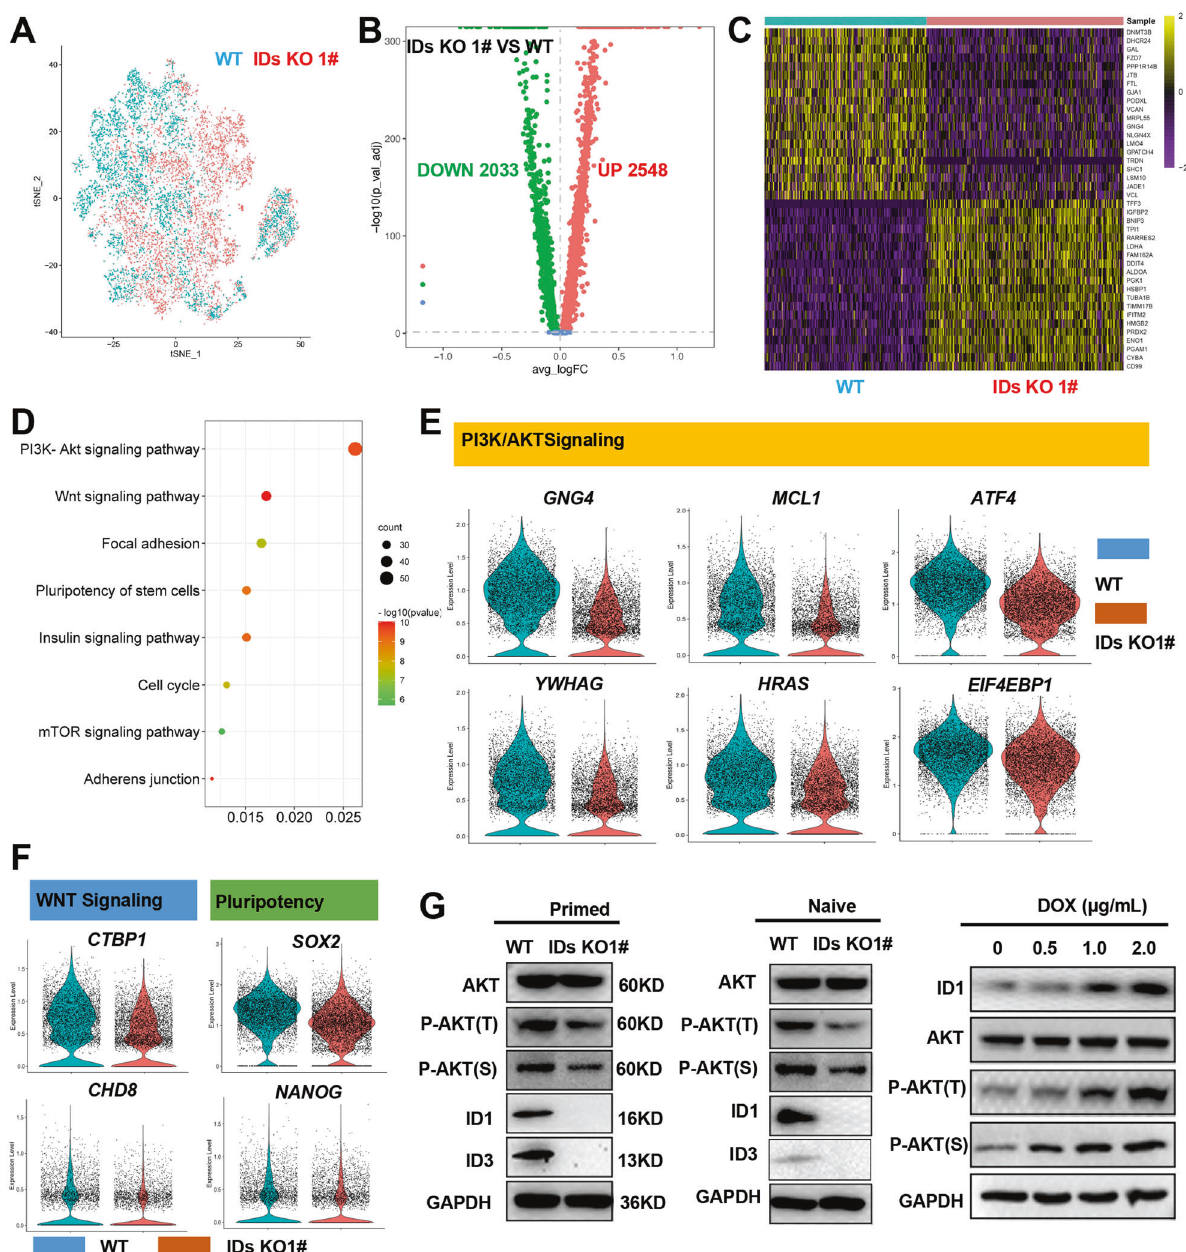
Fig. 4 ID1 and ID3 double knockout reduces AKT phosphorylation of hESCs. A scRNA-seq t-SNE plot of the WT and double knockout line, WT cells are blue, and double knockout cells are red. B Volcano plots showing the fold change (X axis) between the WT and double knockout line cultured in E8 medium. In IDs KO cell, the number of genes with upregulated expression is 2548, and the number of genes with downregulated is 2023. C Heatmap shows the distinct gene expression patterns of the WT and IDs KO. Top 20 DEGs are shown. D KEGG pathway analysis of the genes with downregulated expression in IDs KO compared with WT. E , F Violin plots show the expression distributions of speci fi c marker genes that are enriched in PI3K/AKT pathway ( E ), WNT and pluripotency ( F ). G Western blotting con fi rmed the reduction of AKT phosphorylation of both primed and naive state hESCs and the raise of AKT phosphorylation after ID1